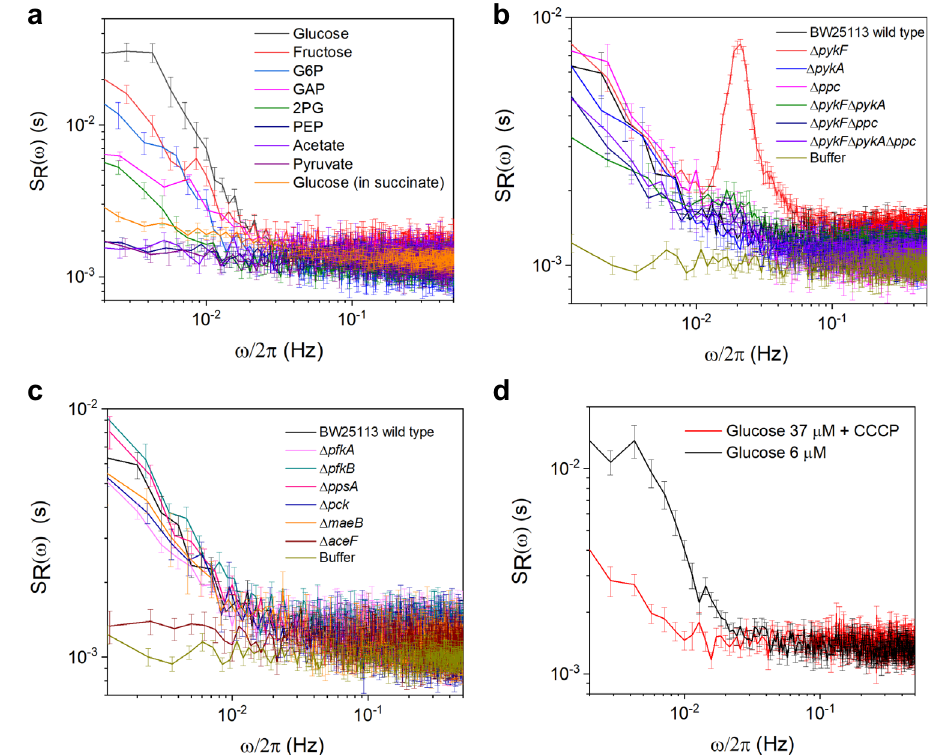
Fig. 4 | Dependence of pyruvate fl uctuations on carbon sources, genetic per- turbationsand energystate.a The averagePSDof the FRETratio fl uctuations for the cells in the presence of different carbon sources and metabolic intermediates. Usedconcentrations were10 μ M glucose, 30mM fructose, 15mM G6P, 7mM GAP, 20mM2PG,5mMPEP,30mMacetateand10 μ Mpyruvate.Fortestingtheglucose response in presence of succinate, cells were fi rst pre-equilibrated in 10mM suc- cinate and then stimulated by 10 μ M glucose in presence of 10mM succinate. The samplesizesare75(fructose),66(G6P),105(GAP),55(2PG),125(PEP),69(acetate), 75 (pyruvate), 83 (glucose) and 236 (glucose in succinate) single cells. b, c The average PSD for the FRET ratio fl uctuations of E. coli BW25113 wild type and its